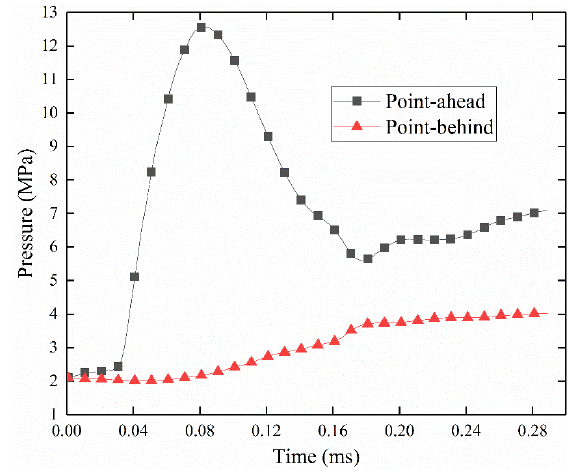
Figure 12. The pressure at two monitoring points during the opening process.